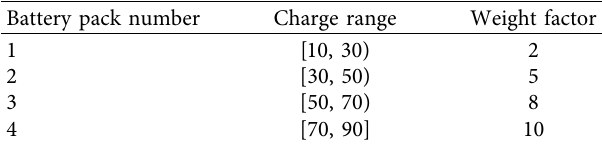
Figure 4: Te block diagram of power distribution strategy in the energy storage power Table 1: Charge grouping of battery pack.